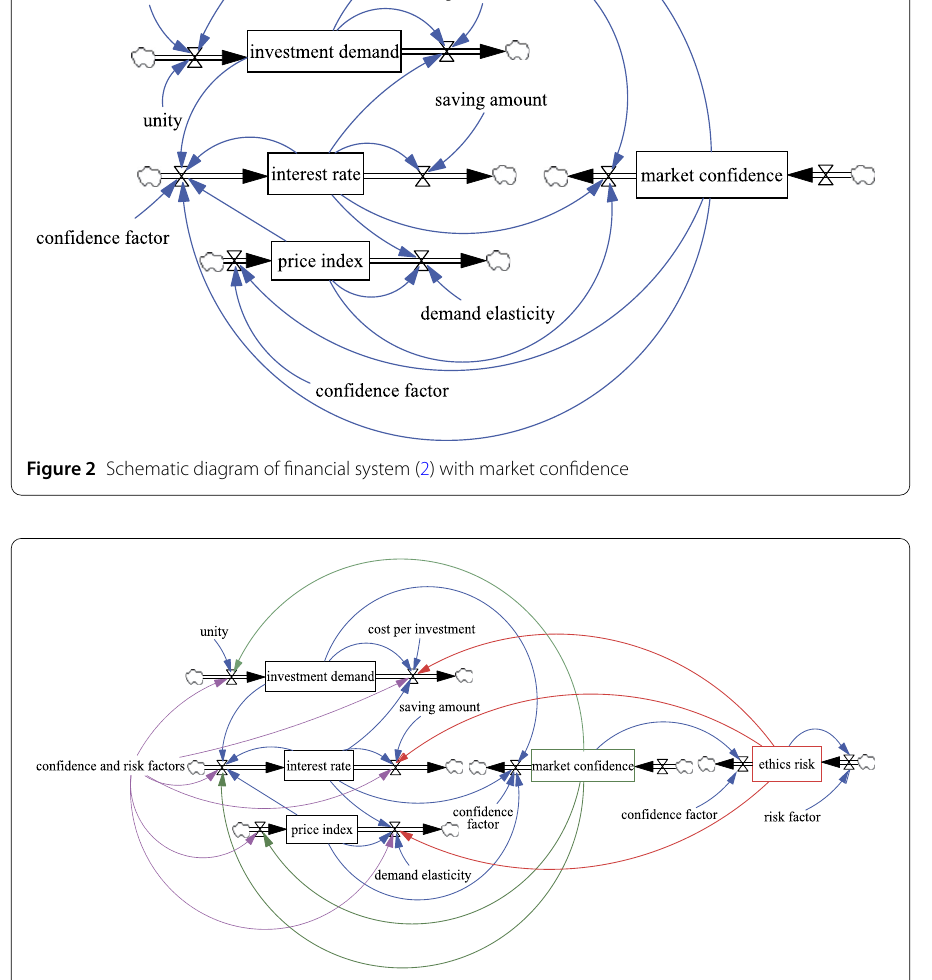
where x , y , z , a , b , c are defined as in system (1), w indicates the market confidence, and m 1 , m 2 , m 3 are the impact